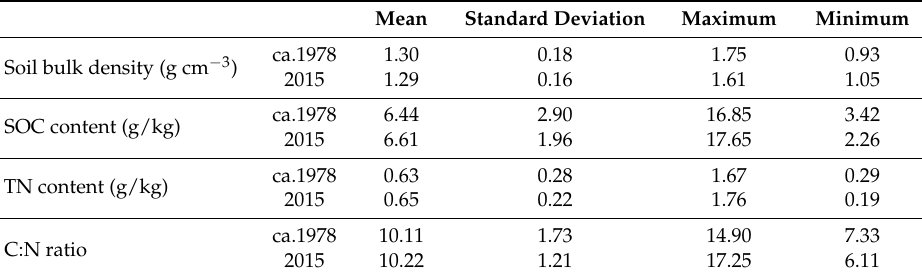
Table 1. Statistical characteristics of soil